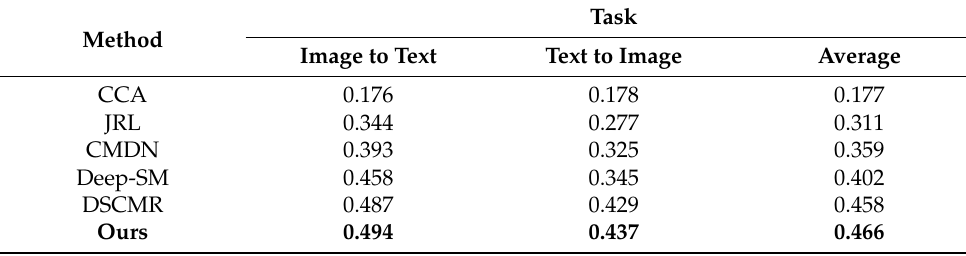
Table 1. The mAP values of the cross-modal retrieval performance on the Wikipedia dataset. Task Method Image to Text